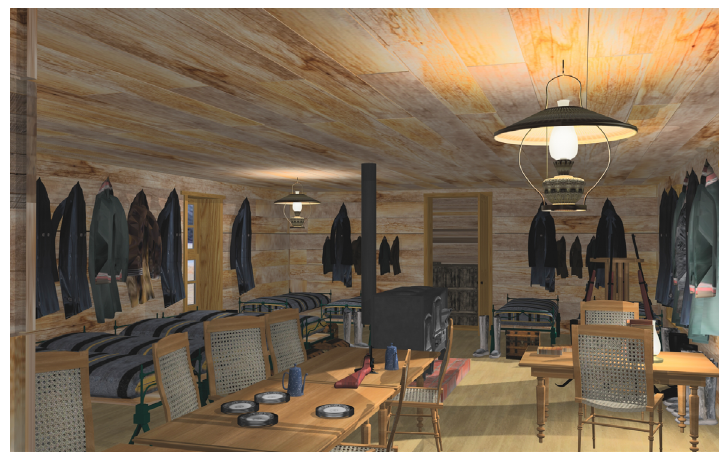
Figure 16. Another view of the enlisted men’s quarters.